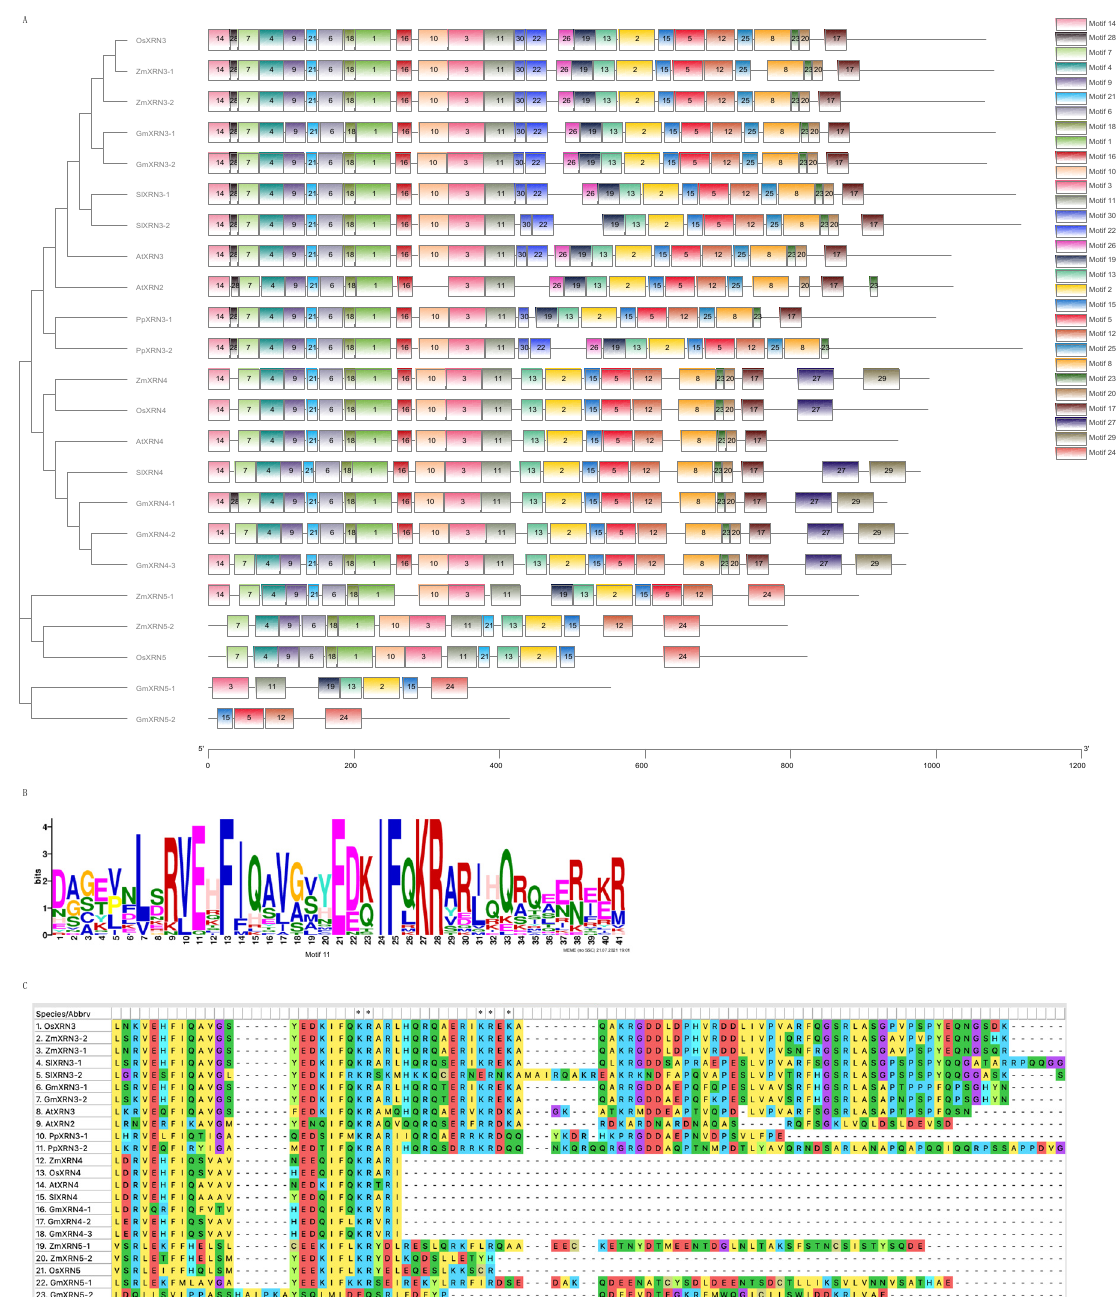
Figure 3. The motif analysis of XRN proteins in 6 plant species. ( A ) The 30 conserved motifs are graphically depicted by differently colored bars corresponding to their predicted positions. ( B ) Motif 11 containing bipartite NLS. ( C ) The multiple alignment result of 23 XRN proteins in the region containing bipartite NLS. The first and second part of key NLS basic amino acid motif were marked with *.